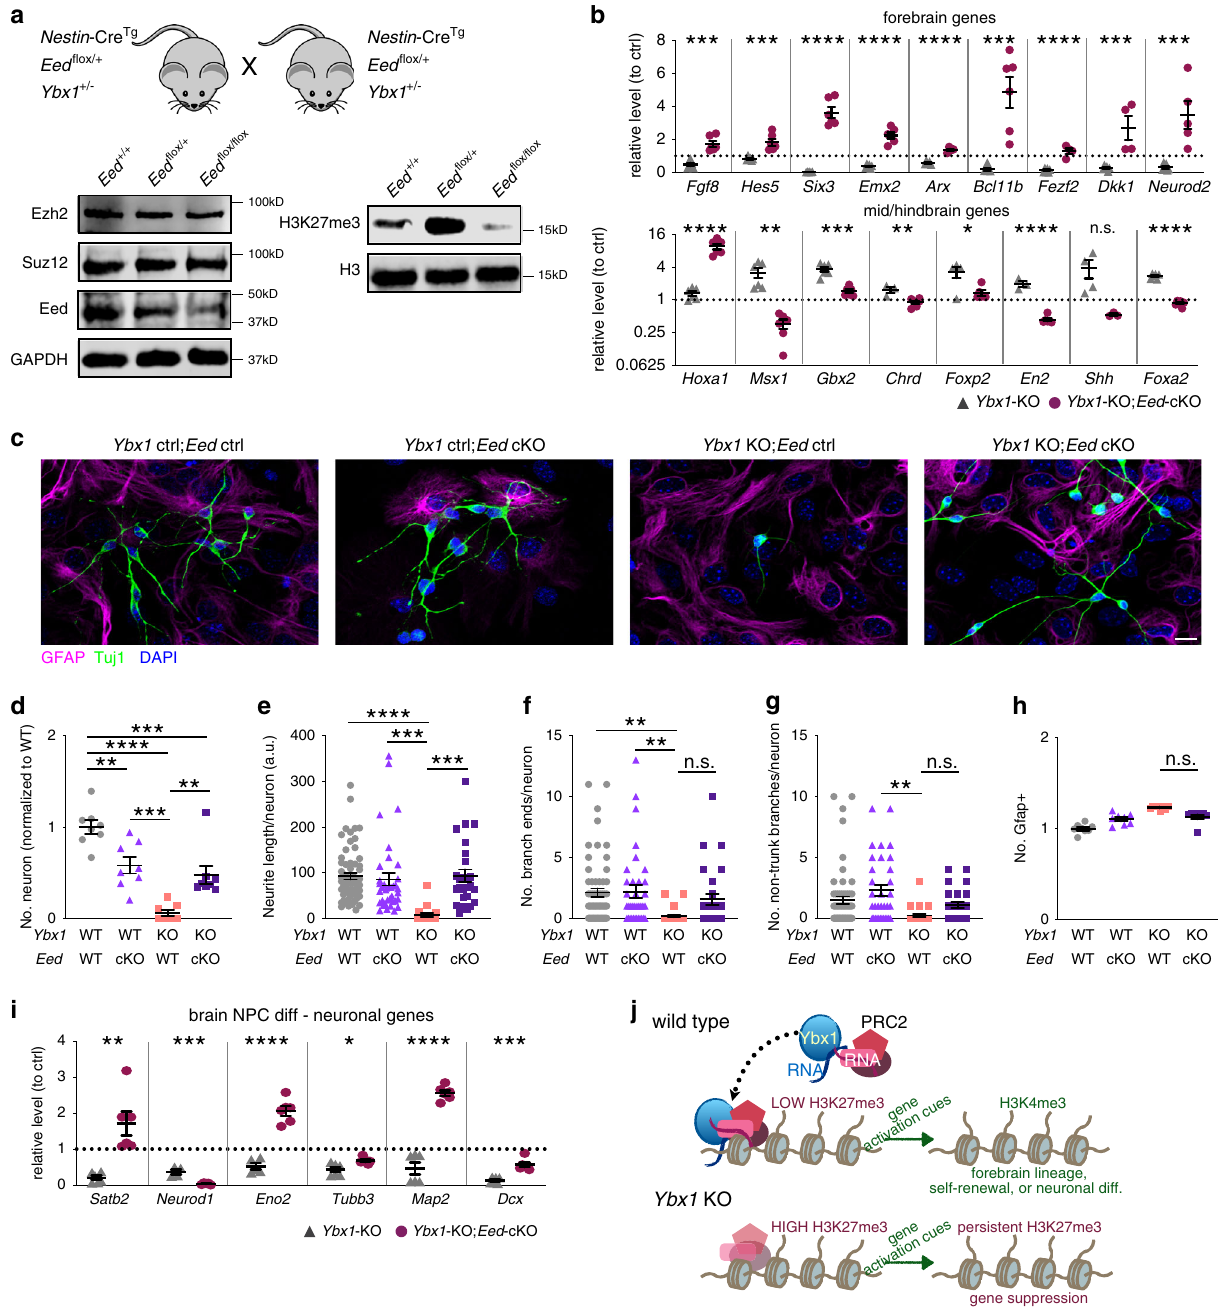
Fig. 8 Depletion of PRC2 subunit Eed partially restores the appropriate gene expression and neuron differentiation in Ybx1 -KO NPCs. a Genetic cross scheme to obtain embryos at E13.5 with Ybx1 -KO or Ybx1-Eed -cKO by Nestin :Cre. WB analysis of Ybx1 -KO NPCs with indicated Eed alleles (all embryos are Nestin:Cre Tg ). b RT-qPCR with TaqMan assays of Ybx1 -KO and Ybx1-Eed -cKO. Relative levels were displayed as their standardization to control NPCs. Dotted line indicates the level of gene expression in control cells. n = 6 except n ≥ 3 for Chrd , En2 , and Shh . c IF analysis of cells with indicated genotypes at day 14 of differentiation. Quanti fi cation of d relative number of Tuj1-positive neurons, e neurite length, f number of branch points in axons, g number of non-trunk branches (not connected to an axon or dendrite), and h Gfap-positive (glial marker) cells in differentiating cells ( n = 8 images). i RT-qPCR with TaqMan assays of neuronal genes in cells after 14 days of differentiation ( n = 6). Dotted line indicates the level of gene expression in control cells. j Model of Ybx1 activities and its in fl uence over PRC2 to ensure spatiotemporal precision in gene activation. Data are presented as mean ± SEM for b , d – i . P values by two-tailed unpaired t test are indicated for b and i and by ordinary one-way ANOVA followed by Tukey ’ s post hoc test in d – h . n.s indicates not signi fi cant. *, ***, and **** indicate P < 0.05, 0.001, and 0.0001, respectively. Source data are provided in Source Data fi le. P values: 8 b